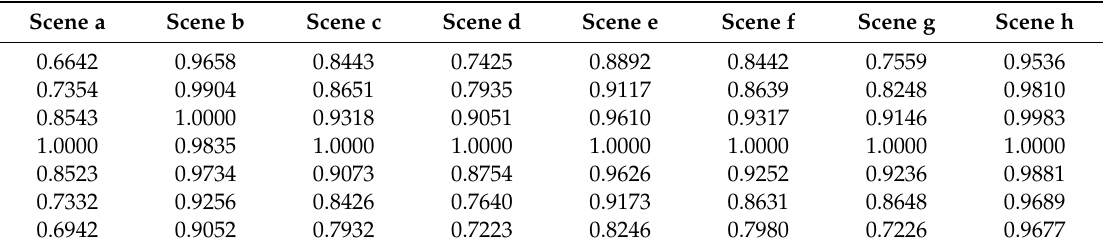
Table 4. The change of the Laplace function during focusing in di ff erent